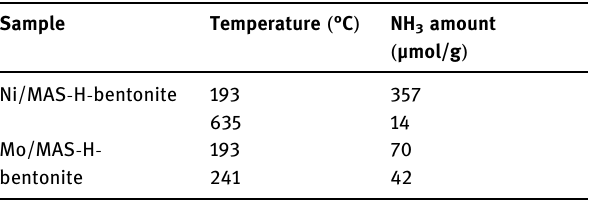
Table 2: Acidity of bifunctional catalysts by TPD - NH